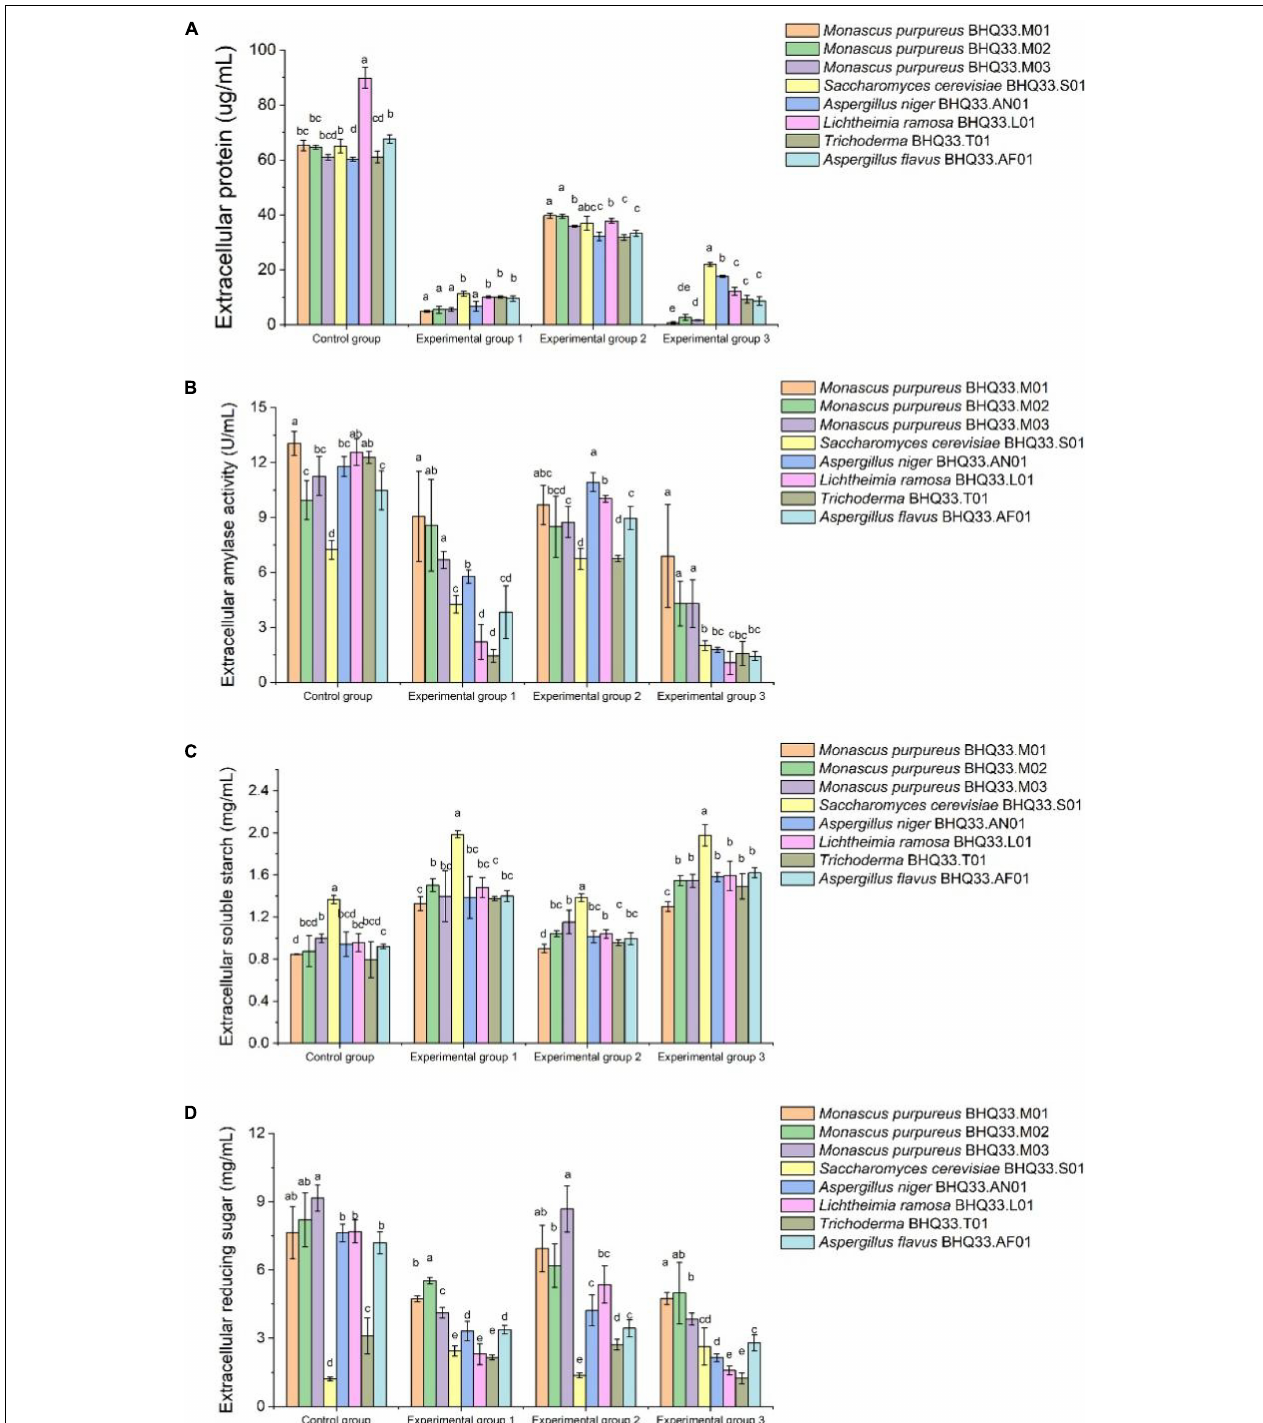
FIGURE 6 | Degradation and utilization of substrates by different fungi isolated from Hongqu BHQ33. Different fungi isolated from Hongqu BHQ33 were cultured in medium containing different concentrations of lactic acid and ethanol at 30 ◦ C and 200 r/min for 24 h, and extracellular protein concentration (A) , extracellular amylase activity (B) , extracellular soluble starch concentration (C) , and extracellular reducing sugar concentration (D) were detected. In the initial medium, control group was basal medium without lactate and ethanol, experimental group 1 was supplemented with 3.98% (v/v) lactic acid in basal medium, experimental group 2 with 6.24% (v/v) ethanol, and experimental group 3 with both 3.98% (v/v) lactic acid and 6.24% (v/v) ethanol. Error bars indicate the standard deviation (SD) of the means ( n = 3), and different lowercase letters represent significant differences in the detection indexes of fungi isolated from Hongqu BHQ33 under the same treatment conditions ( p <